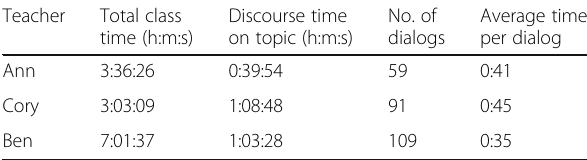
Table 4 Comparison of each teacher ’ s classroom dialog time